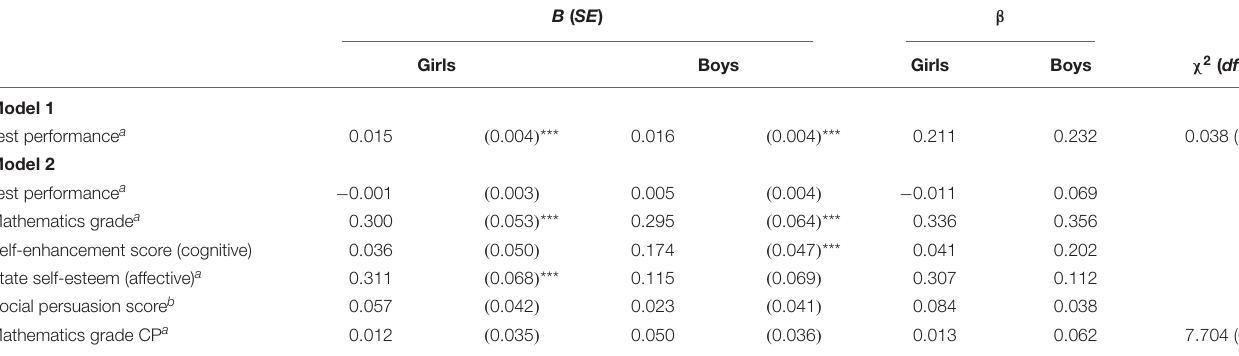
TABLE 3 | Regression models predicting students’ mathematics self-efficacy for girls and boys. B ( SE ) β Girls Boys Girls Boys χ 2 ( df